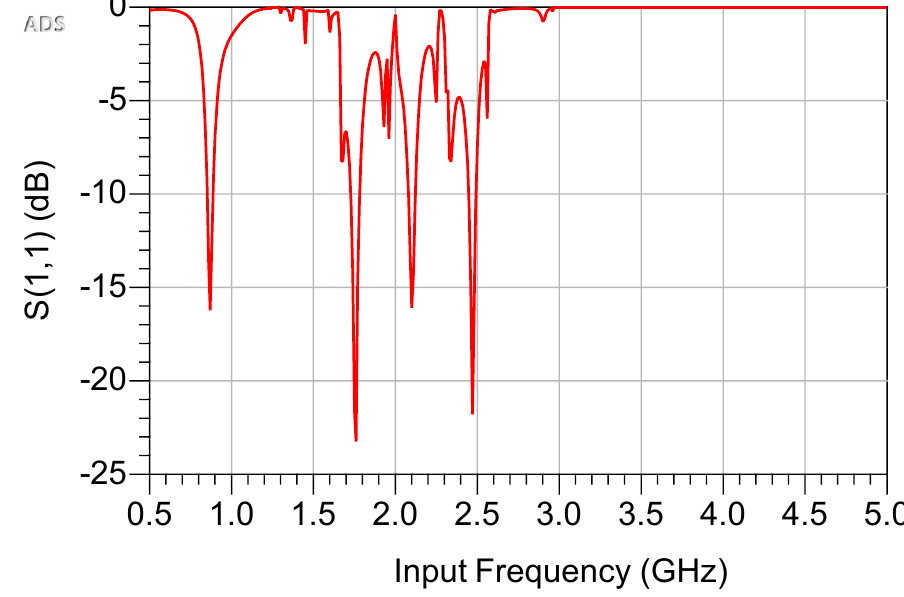
Figure 12. S-parameters of the proposed quad-band circuit with a single receiving